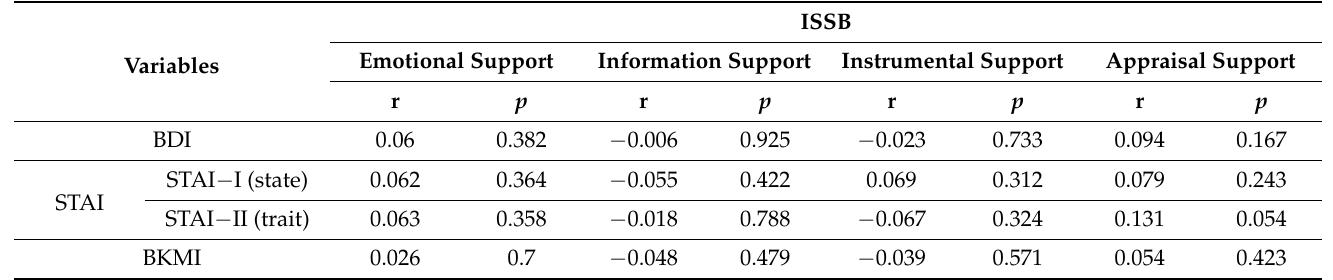
Table 6. Correlations between social supports and occurrence of depression according to the BDI, anxiety according to the STAI, Climacteric symptoms according to the